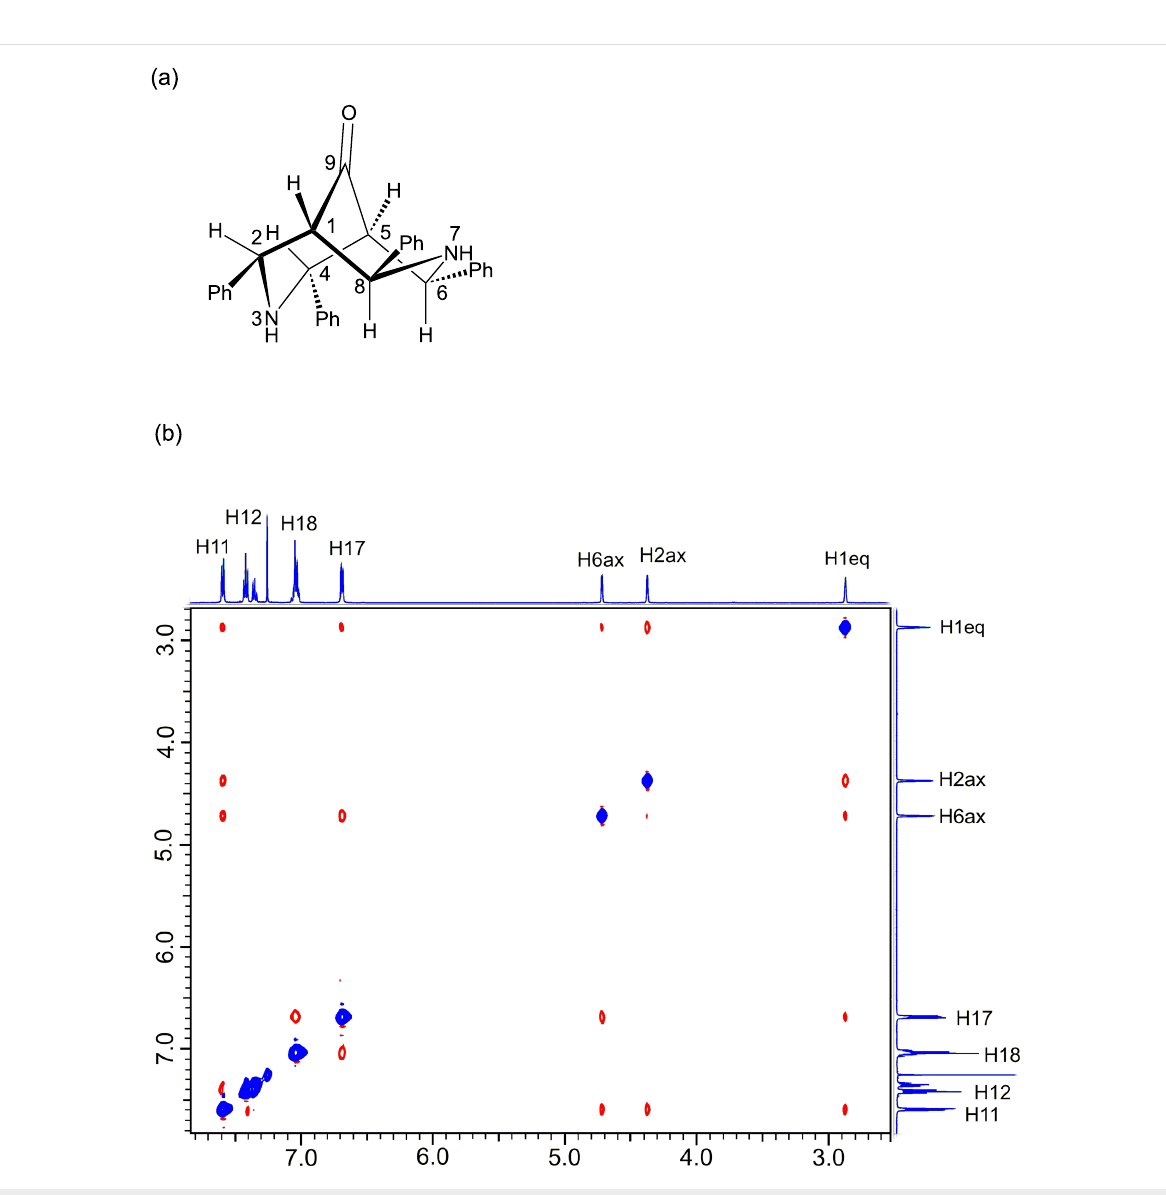
chair–boat conformation, because one nitrogen atom is substi- tuted by a methyl group. As a result, LPE repulsion is absent in compounds 3 – 8